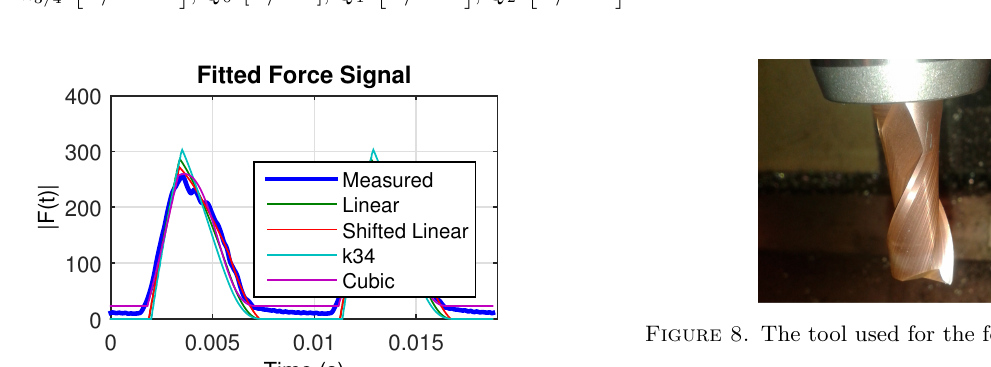
Table 1. Fitted parameters where the units are given as follows: k (cid:2) N / mm 2 (cid:3) , k